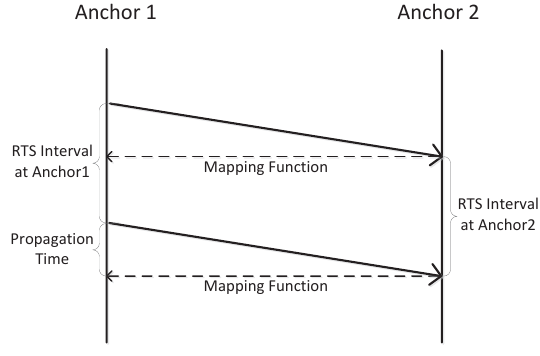
Figure 2: Synchronization Using Two Consecutive Rounds We suppose anchor 1 is sending and synchronize anchor